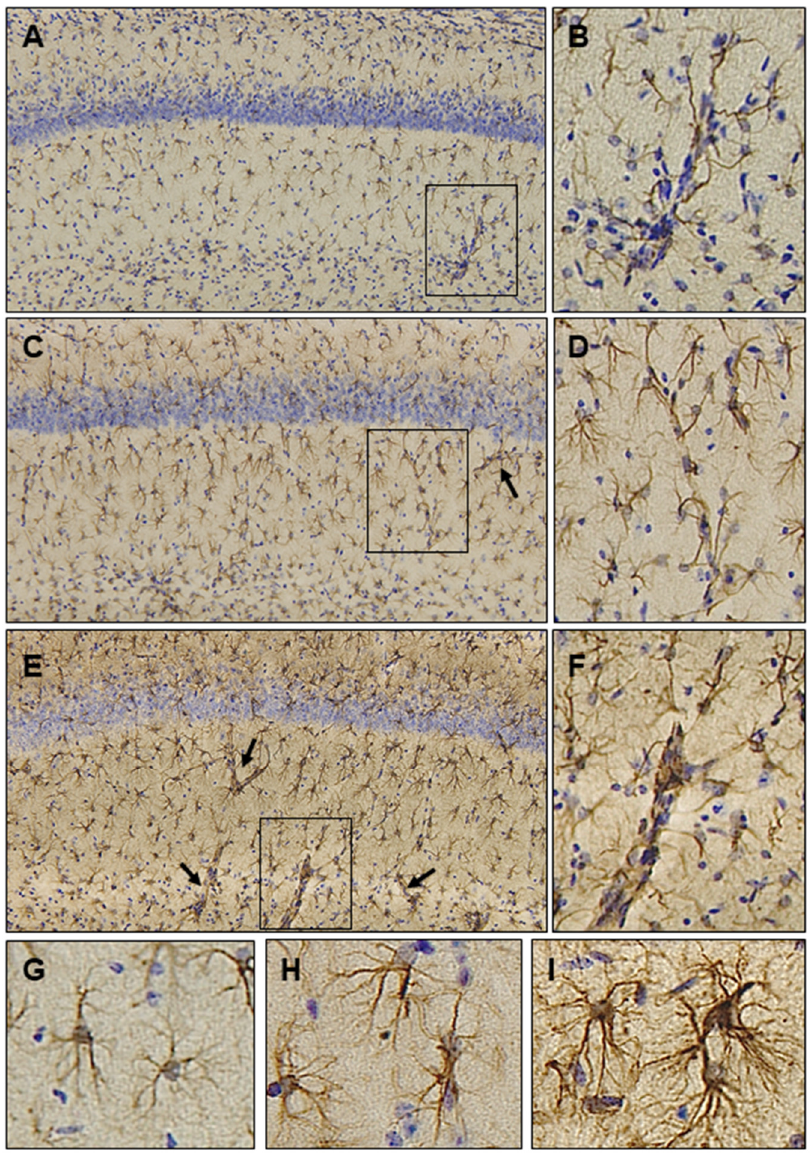
Figure 3. Astrocytic responses to Ubisol-Q 10 supplementation in the MPTP model of Parkinson’s disease. Formalin fixed free-floating sections were subjected to immunohistochemistry using an antibody raised against glial fibrillary acidic protein (GFAP), a widely used marker of astrocytes. Astrocytes were identified by a brown precipitate at the site of antigen-antibody reaction. Nuclei were counterstained blue with hematoxylin. Shown are photomicrographs at the level of hippocampus from control ( A ), MPTP-injected ( C ) and MPTP-injected mice receiving Ubisol-Q 10 ( E ); Magnification = 20×. Arrows in panels A, C and E depict cerebral microvasculature with increased GFAP staining forming the perivascular astrocyte endfeet. Boxed areas are represented at a higher magnification—control ( B ), MPTP-injected ( D ) and MPTP-injected mice receiving Ubisol-Q 10 ( F ). High magnification image of activated astrocyte morphology with increased GFAP staining is shown in MPTP-injected ( H ) and MPTP-injected mice receiving Ubisol-Q 10 ( I ) as compared to controls ( G